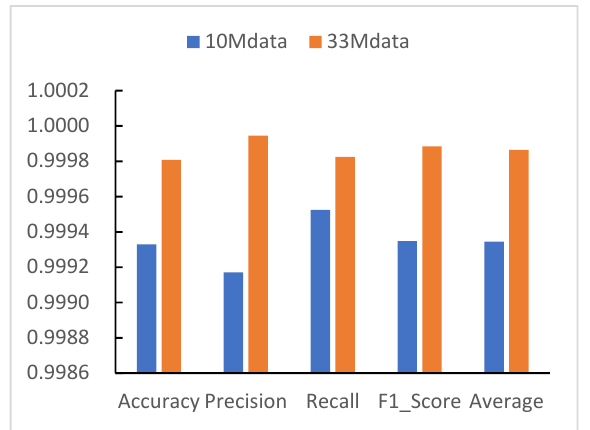
Figure 28. Performance comparison with changing DDoS dataset.